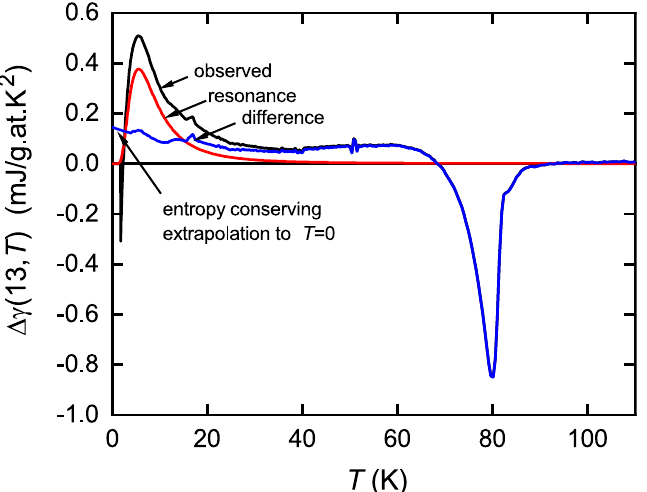
Figure 8. Black curve: the as-measured field-induced differential specific heat coefficient, �γ( 13, T ) γ( 13, T ) γ( 0, T ) . Red curve: resonance γ( T ) as calculated using Eq. (8). The blue curve is = −